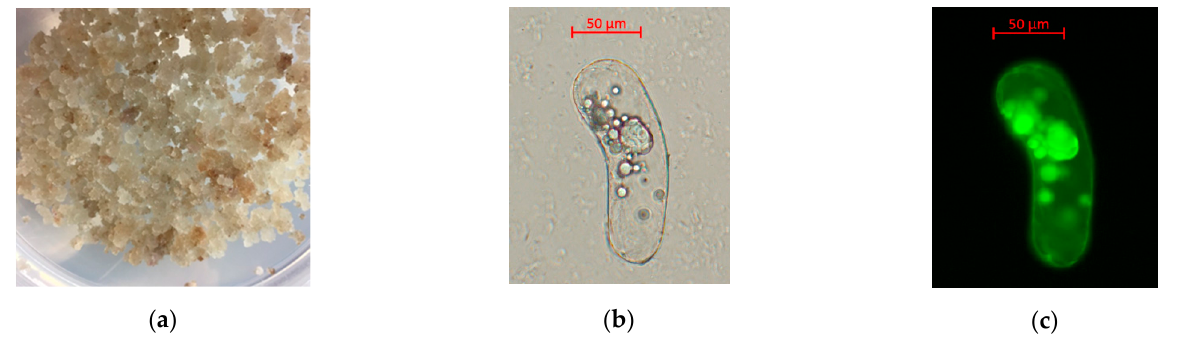
Figure 1. Melissa officinalis cell culture maintained in solid MO medium: ( a ) cells of the Melissa officinalis seen under an AXIO-Imager A2 optical microscope (ZEISS), in the bright field mode ( b ) and after staining with fluorescein diacetate ( c